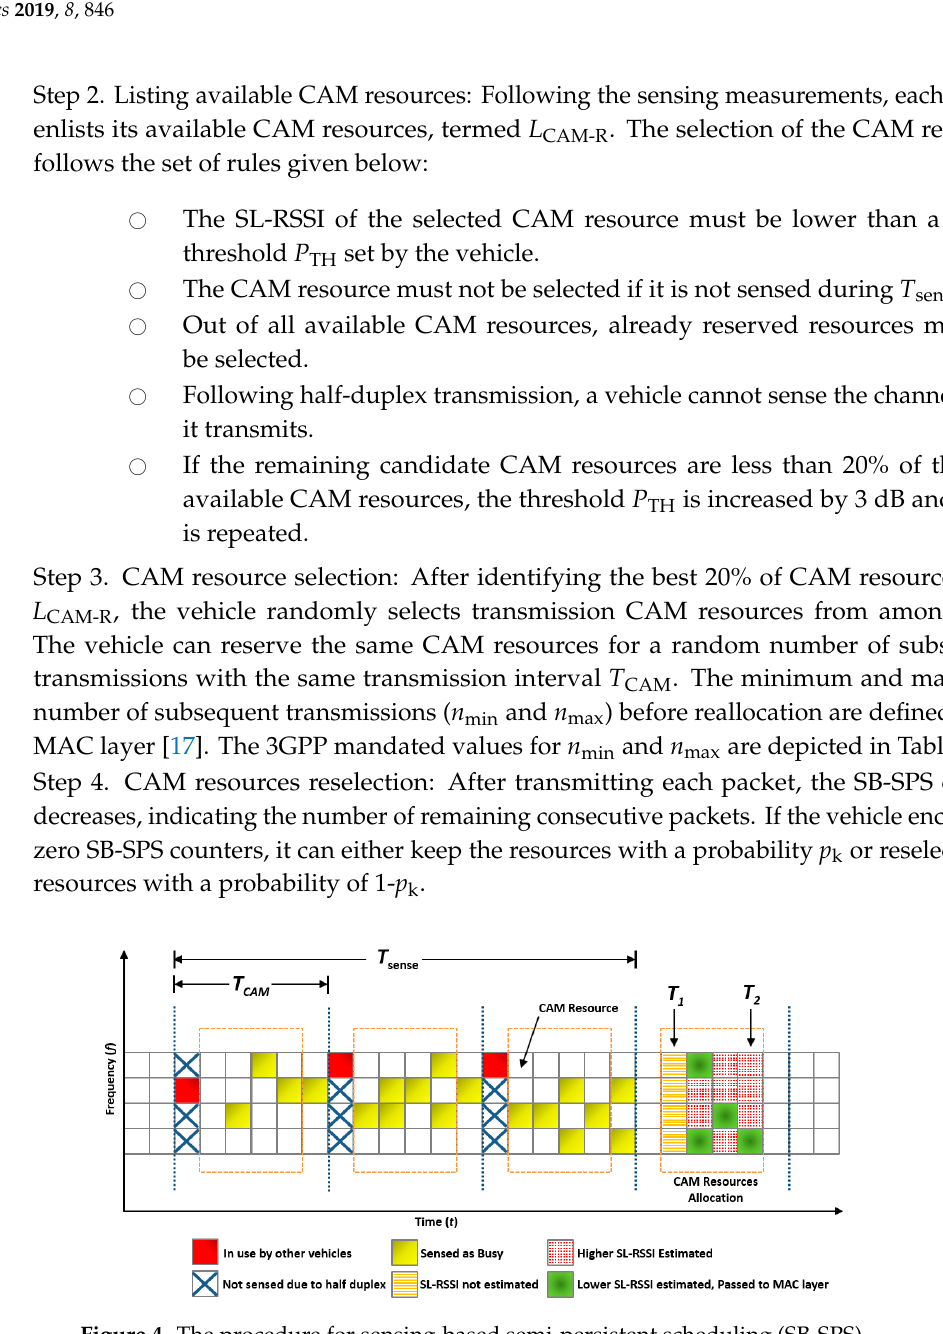
Figure 4. The procedure for sensing-based semi-persistent scheduling (SB-SPS). Table 1. Physical and MAC layer parameters for Mode 4 along with the values defined by 3GPP.